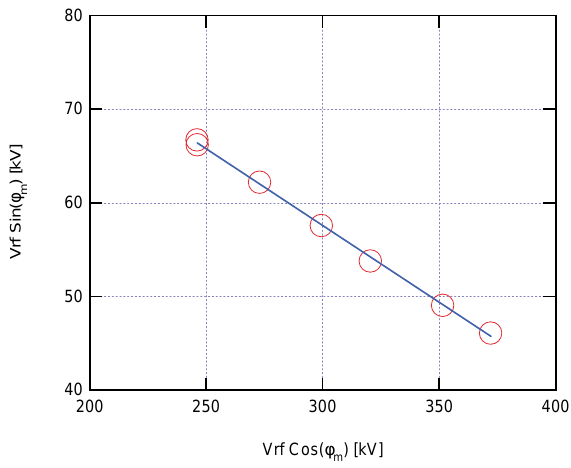
FIG. 5. (Color) Synchronous phase shift as a function of rf voltage at 1.15 GeV. Beam current is 8.3 mA.